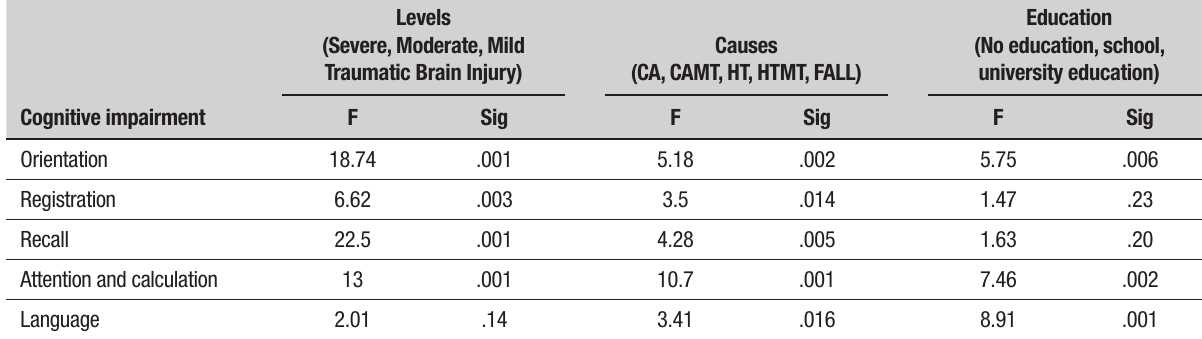
Table 1. Impacts of levels and causes of traumatic brain injury and education on dimensions of cognitive impairment. Levels